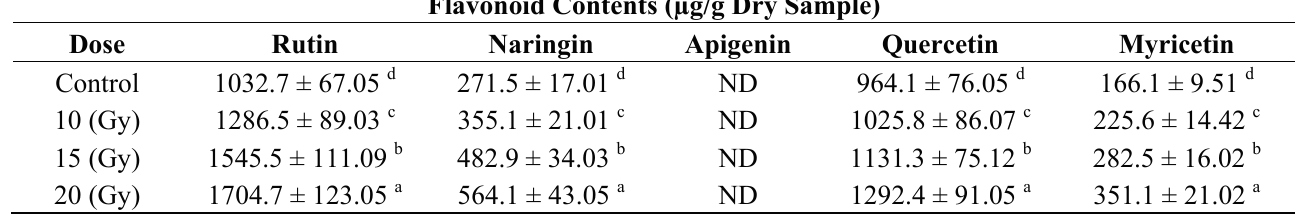
Table 3. Concentration of different flavonoids compounds in the leaves of C. alismatifolia var. sweet pink under different dose levels of acute gamma irradiation (Mean ± SEM; n =